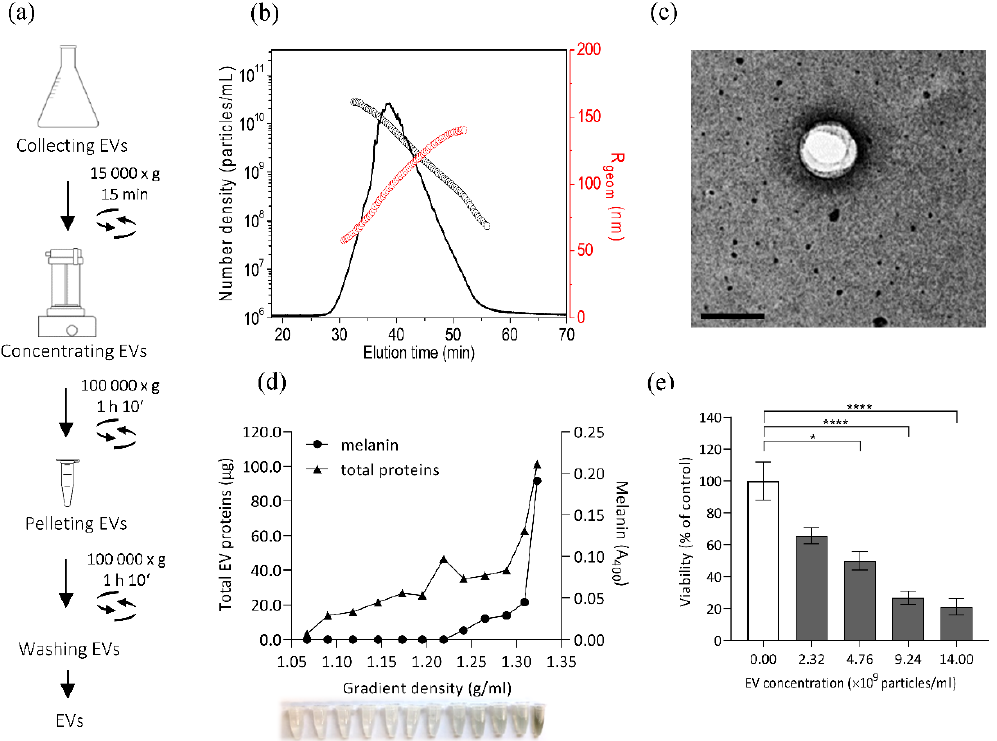
Figure 4. Extracellular vesicles (EVs) from E. dermatitidis show cytotoxic effects on SH-SY5Y cells . ( a ) EV isolation from 15 h old E. dermatitidis culture was performed according to the scheme. ( b ) E. dermatitidis EVs were characterized for morphology by asymmetrical-flow field-flow fractionation analysis coupled to a multidetection system (AF4-MALS). Normalized AF4-MALS fractogram (black line) of EVs for R geom (red circles) and number density (black circles) is presented. ( c ) Transmission electron microscopy (TEM) micrograph of EV; scale bar: 200 nm. ( d ) E. dermatitidis EVs were subjected to velocity gradient centrifugation and the collected fractions were analysed for density, total EV proteins (µg), and melanin content (A 400 ). ( e ) The cytotoxic effect of E. dermatitidis EVs on SH-SY5Y cells, as measured by the neutral red uptake viability assay. Data are presented as the mean ± SD of two independent experiments, where the white bar represents viability of control without added EVs (100%) (* p < 0.05; **** p < 0.0001; Kruskal–Wallis statistics).